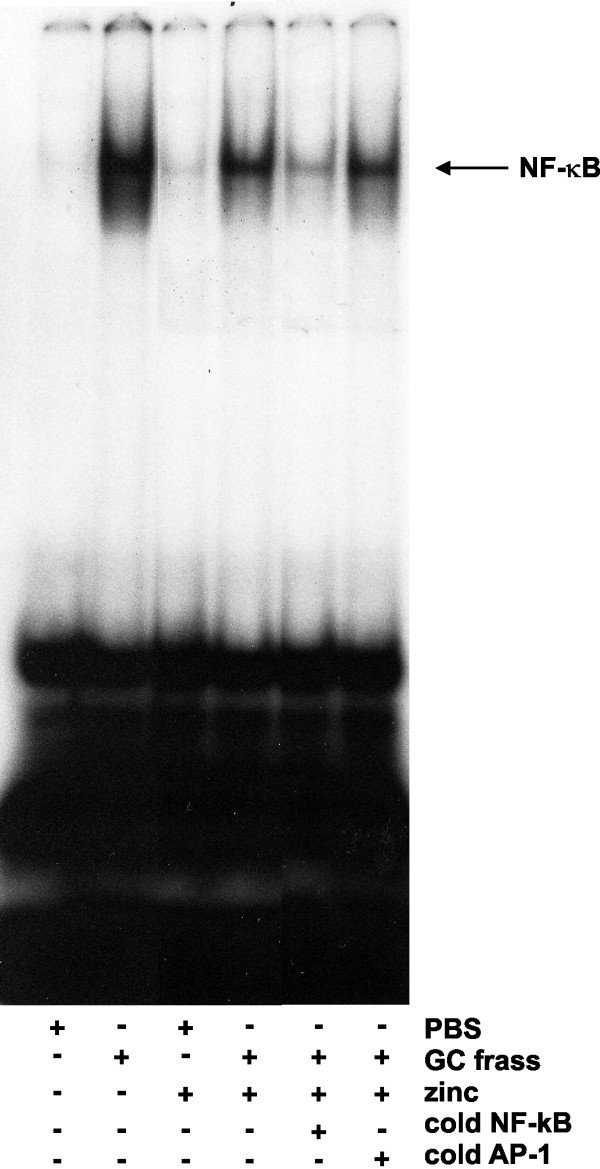
Zinc supplementation decreased NF-κB-DNA binding in whole lung. Mice were given daily i.p. injections of PBS or zinc gluconate (10 mg/kg) for 3 days prior to a single i.t. inhalation of PBS or GC frass (40 μg/40 μl). 4 h later, whole lungs were removed and snap frozen. Lungs were homogenized, nuclear extracts isolated and analyzed by EMSA. NF-κB-DNA binding is shown, top arrows designate supershift of p65 and p50. Data shown are representative from a single mouse (n = 3 mice per group).